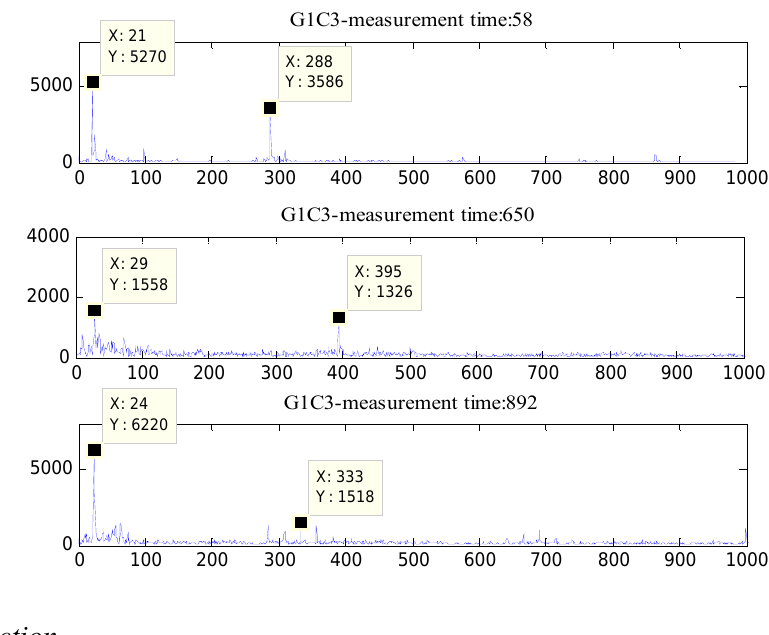
Figure 4. The frequency spectra of the vibrations collected from the oil sand